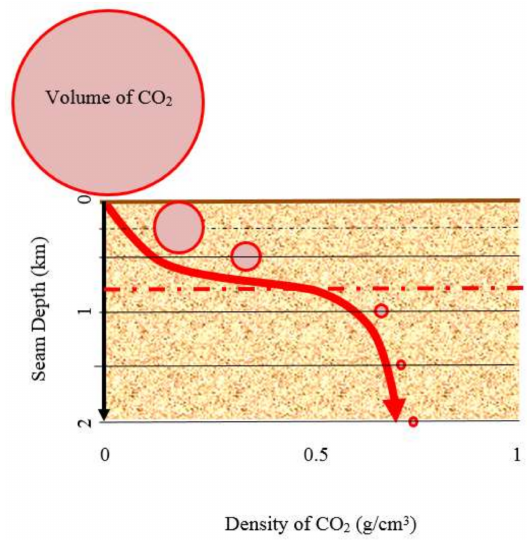
Figure 9. Variation of volume occupied by CO 2 with depth [53].